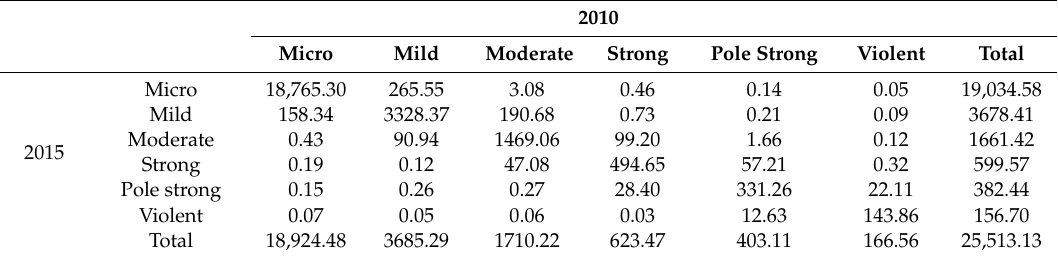
Table 7. The transfer matrix of soil erosion intensity grades in the Taohe River Basin from 2010 to 2015 (km 2 ).